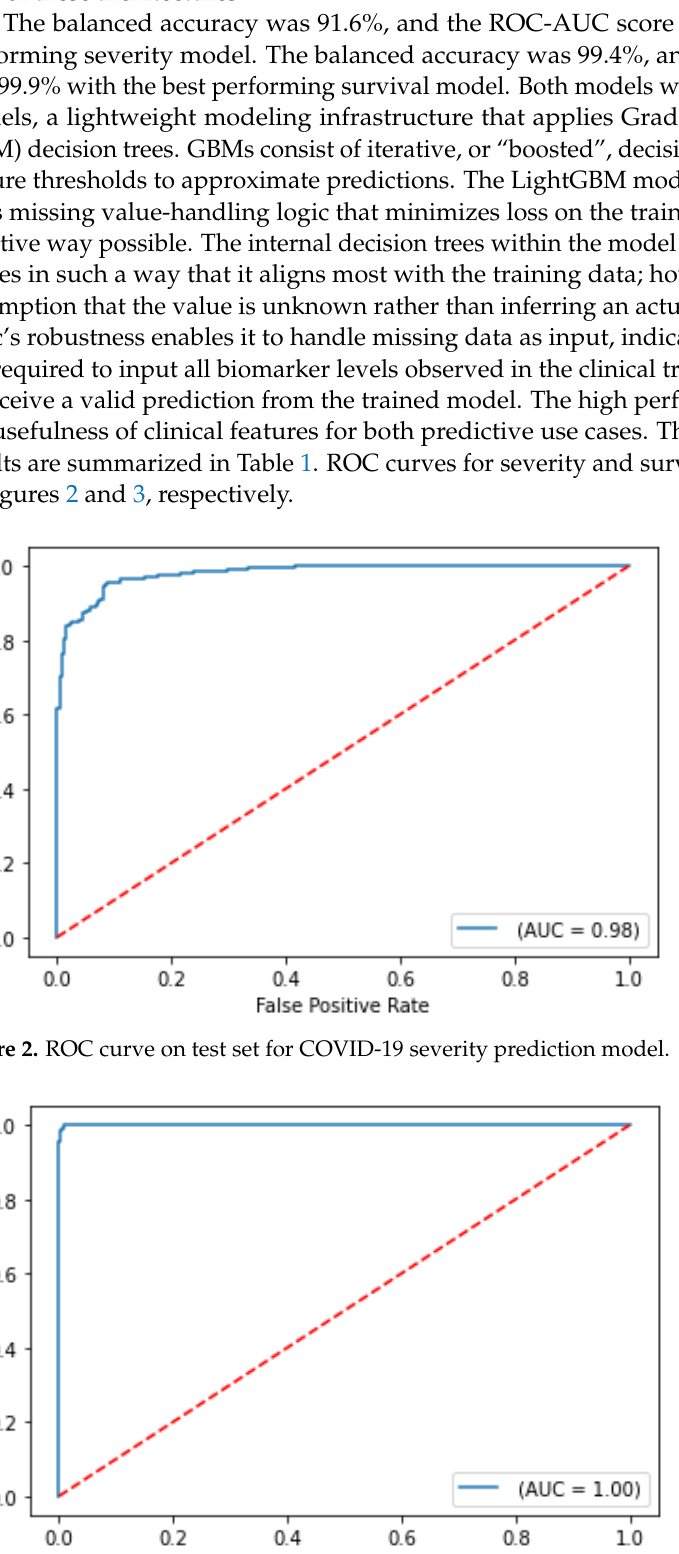
Figure 3. ROC curve on test set for COVID-19 survival prediction model.